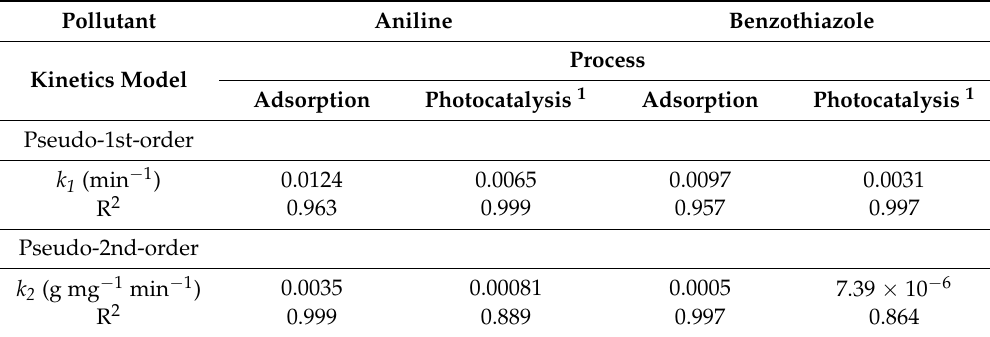
Table 6. Determined kinetic parameters of adsorption and photocatalysis processes for the removal of aniline or benzothiazole with TiO 2 catalyst. Experimental conditions: C 0 = 22.0 mg L − 1 ; T = 25.0 ◦